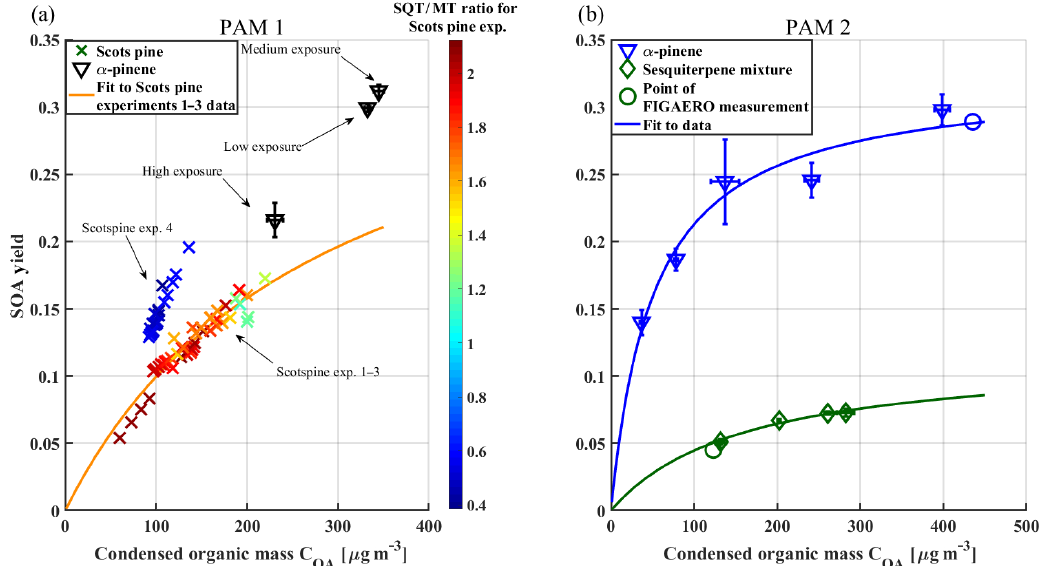
Figure 3. (a) SOA yield vs. condensed organic mass ( C oa ) from Scots pine and α -pinene experiments. Each point represents a single SMPS scan. In these cases, error bars are omitted for clarity. The colour scale of the Scots pine experiment results corresponds to the sesquiterpene- to-monoterpene (SQT / MT) ratio by mass ratio (crosses; showing all yield measurements, reflecting the variability in plant emission rates). Each α -pinene experiment is averaged to one point (black triangles) and labelled. Error bars shown are standard deviations of multiple scans. The orange curve is fit with Eq. (2) to the Scots pine experiments 1–3 (SQT / MT > 1) with the following fit parameters: α 1 = 0 . 3783, K 1 = 0 . 0035, α 2 = 0 . 0029 and K 2 = 0 . 0035. (b) α -pinene reference and sesquiterpene mixture SOA yields versus C OA and Odum fits to both datasets. The fit parameters are α 1 = 0 . 3219 and K 1 = 0 . 0195 for α -pinene and α 1 = 0 . 1164 and K 1 = 0 . 0062 for the sesquiterpene mixture. Circles show the points of FIGAERO measurements. Titles PAM 1 (a) and PAM 2 (b) refer to different PAM reactors used in the